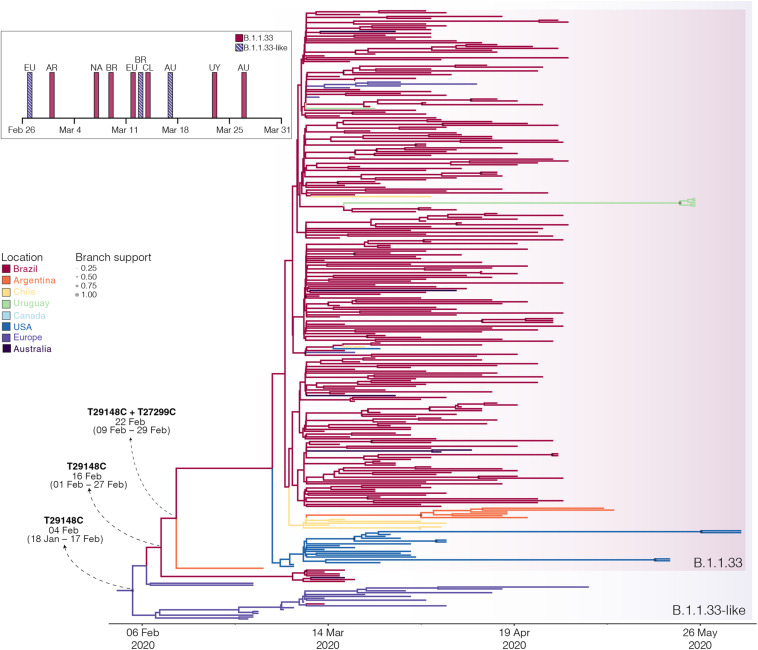
Spatiotemporal dissemination of the SARS-CoV-2 clades B.1.1.33-like and B.1.1.33. Time-scaled Bayesian phylogeographic MCC tree of the major B.1.1 lineages circulating in Brazil. Branches are colored according to the most probable location state of their descendent nodes as indicated at the legend. Circle sizes at internal nodes are proportional to the corresponding posterior probability support as indicated at the legend. The inferred TMRCA (based on the median of the posterior heights) and nucleotide substitutions fixed at ancestral key nodes are shown. Shaded boxes highlight the position of the clades B.1.1.33-like and B.1.1.33. The tree is automatically rooted under the assumption of a strict molecular clock, and all horizontal branch lengths are drawn to a scale of years. The inset figure depicts the timeline of the earliest detection of clades B.1.1.33-like (blue dashed bars) and B.1.1.33 (red bars) in Europe (EU), North America (NA), Australia (AU), Argentina (AR), Brazil (BR), Chile (CL), and Uruguay (UY).